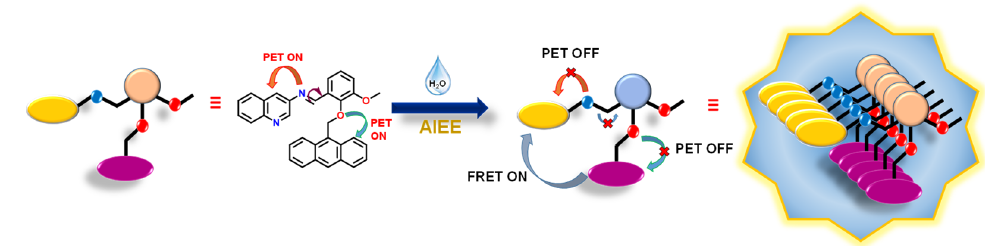
Figure 3 . Absorption spectra of chemosensors ( a ) L1 (c, 20 μM) and ( b ) L2 (c, 20 μM) in EtOH in the presence of assorted metal ions (c, 50 μM). 3.5. Detection of Al 3+ and Ga 3+ Ions by Fluorescence Spectral Studies The emission spectra of both chemosensors L1 (c, 20 μM) and L2 (c, 20 μM) were measured in the presence of 2.5 equiv. of different metal ions: Ag + , Cd 2+ , Mn 2+ , Zn 2+ , Hg 2+ , K + , Na + , Co 2+ , Pd 2+ , Mg 2+ , Pb 2+ , Be 2+ , Ni 2+ , Sn 2+ , Li + , Cr 3+ , Fe 2+ , Fe 3+ , Cu 2+ , Al 3+ , Ga 3+ , and In 3+ (Figure 4). In the case of L1 , the emission spectral profile remained unchanged in the pres- ence of nearly all the metal ions except for the Al 3+ and Ga 3+ ions. It is significant to note that L1 showed a ‘turn-on’ response in the presence of both Al 3+ and Ga 3+ ions with the observation of a new emission band at 465 nm. In contrast, L2 displayed an enhanced emission at 430 nm only in the presence of Ga 3+ ions while no change was noted with the